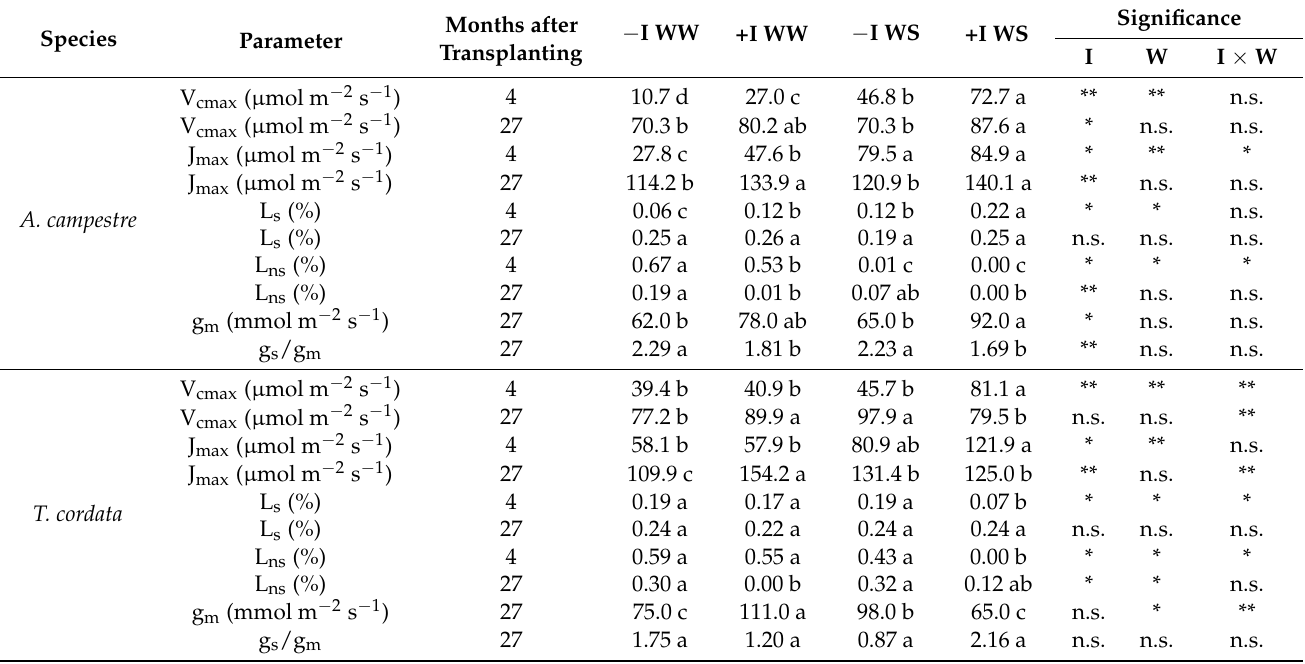
Table 3. Effect of mycorrhizal inoculation and water regime in the nursery on stomatal (L s , %) and relative mesophyll limitations (L ns , %), apparent maximum rate of carboxylation by Rubisco (V cmax , µ mol m − 2 s − 1 ), apparent maximum electron transport rate for ribulose 1,5-BP regeneration (J max